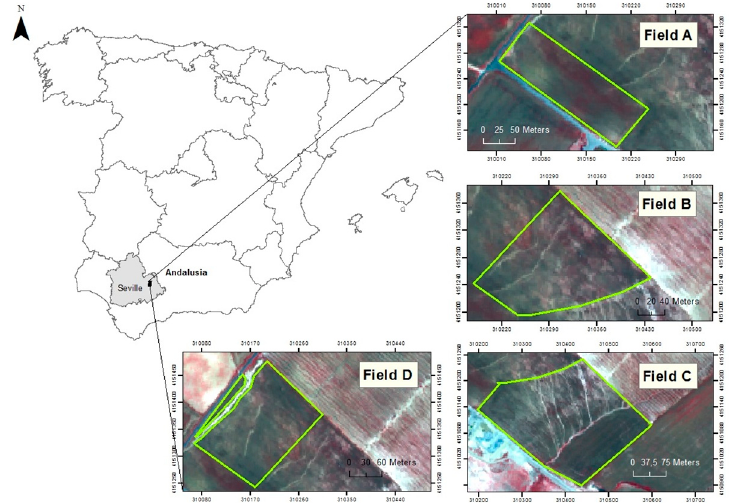
Figure 1. Location of study area in Andalusia, southern Spain. Detailed wheat fields are depicted by QuickBird multispectral image.